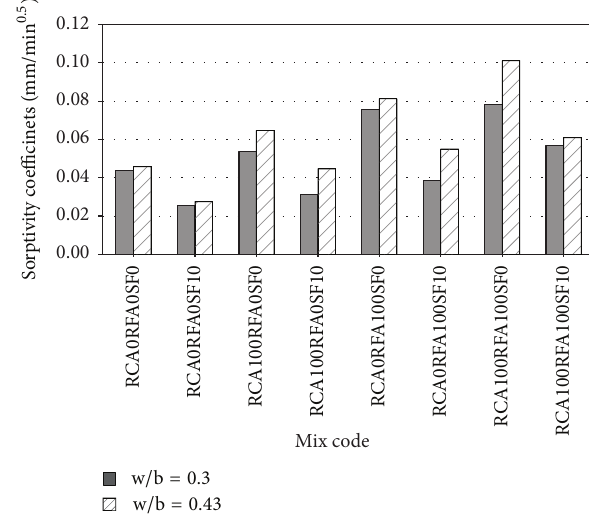
Figure 9: Water sorptivity test results at 56 days.